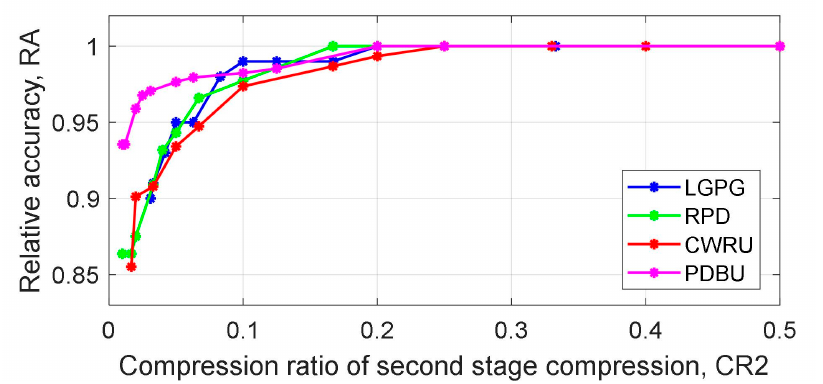
Figure 3. Relationship between 2nd stage compression ratio and relative accuracy.